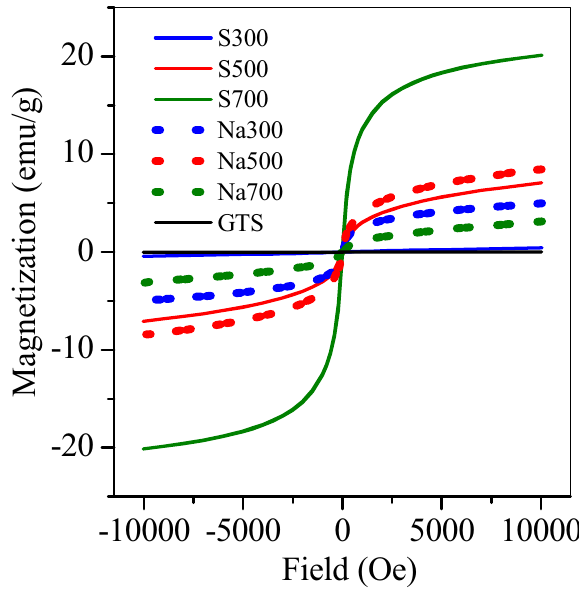
Figure 1. Hysteresis loops of GTS and the prepared